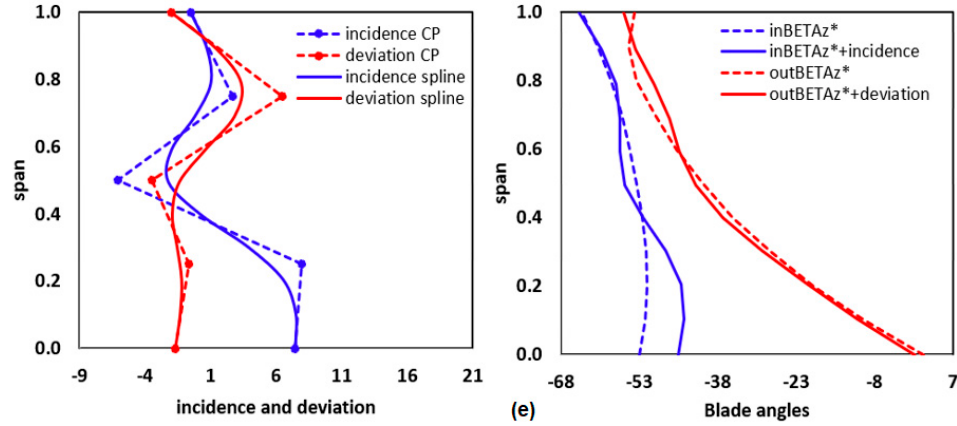
Figure 18. Geometry and y+ on the blade surfaces of the first 1.5 stages of the high-pressure com- pressor in (a)-(b). Domain axisymmetric view in (c), 50% span b2b grid in (d), and spanwise defini- tion of blade metal angles (BETAz*) with incidence and deviation as B-spline control points in (e). The Phase 1 optimum rotor was further used in Phase 2 optimization as a baseline by varying the meanline curvature of the airfoil chordwise and spanwise using cubic B-spline control points. At each span, six chordwise control points ( u, curv ) define the curvature, of which the first and last two have zero curvature to clamp the spline at LE and TE. This definition is smoothly repeated for all five spanwise locations to create a 3D blade. In this optimization, there were three control points for curvature definition ( curv ) at fixed chord- wise locations and one chordwise location itself ( u ) varied, and this was defined at five spanwise locations where the hub and 25% spanwise variables were identical to each other. Hence, 16 geometrical parameters (4 per span) were varied in total. In Figure 19, chordwise curvatures for all the spans are plotted, and for spans above 75%, there exist 2 inflection points where the curvature changes direction, which leads to an S-shaped air- foil. This optimized 3D shape has a better pressure gradient compared to the optimum of Phase 1, as shown in Figure 19, which also indicates flow separation minimization due to the improved radial flow. Hence, a stage efficiency of 88.08% is achieved with an improve- ment of 1.67%, and an isolated rotor efficiency of 90.66% is achieved with an improvement of 1.42%.